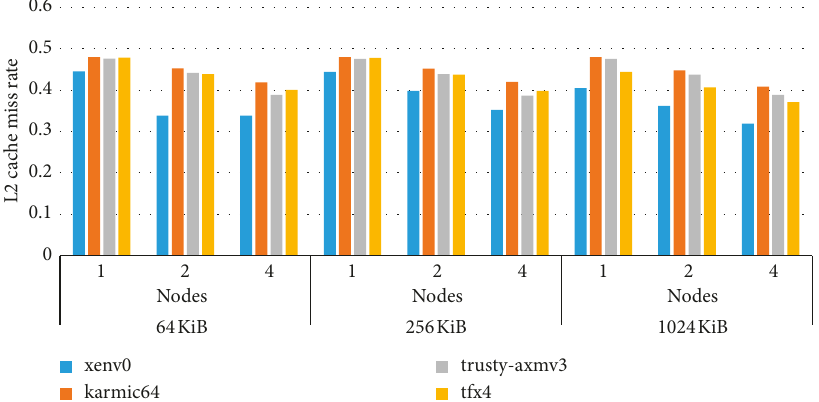
Ubuntu 16.04, “karmic64” Ubuntu (cid:31) (cid:31)